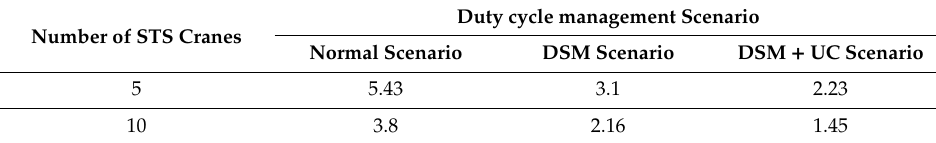
Table 6. Rated peak factor ( P ∧ F ) for the STS crane group in di ff erent scenarios. Number of STS Cranes